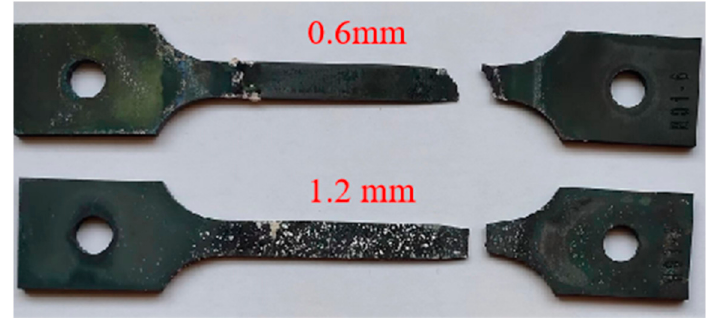
Figure 14. The morphology of the ruptured thin-walled specimens.